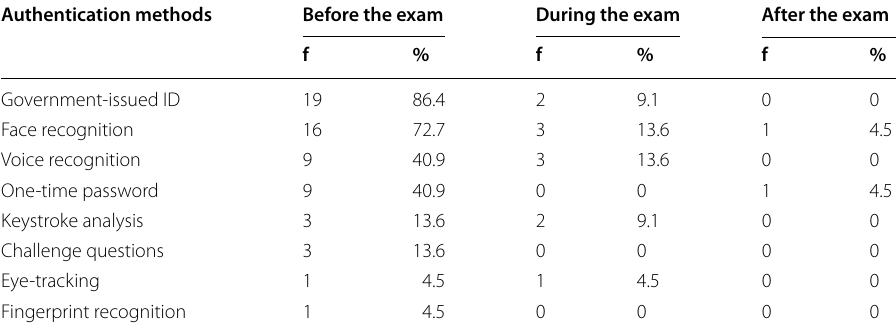
Table 4 Authentication methods used in online assessment systems Authentication